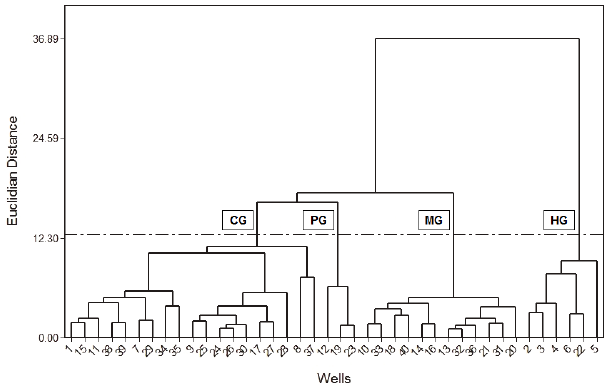
areas of urbanized Guadalajara, except for Toluquilla wells where values ascend to 2300 µS cm − 1 . The CG ( n = 19) is a Na-HCO 3 water type located in recharge zones in the west- ern portion and reflects a short (local) groundwater flow path with poor circulation. It shows low temperatures (av- erage 25.3 ◦ C) and salinity (254 µS cm − 1 ) , however elevated NO 3 -N (9.1 mg L − 1 ) values, possibly derived from agricul- tural practices. Groundwater in the discharge area in cen- tral Guadalajara evolves to a Na-SO 4 to mixed-HCO 3 water type (PG, n = 3), with higher concentrations of several ele- ments, indicating an important impact from anthropogenic pollution, i.e., SO 4 (70.6 mg L − 1 ) , NO 3 -N (12.4 mg L − 1 ) , Na (52.2 mg L − 1 ) and Cl (38.9 mg L − 1 ) .Groundwater that moves in northern and eastern direction attains a Na- HCO 3 to mixed HCO 3 water type (MG, n = 12), with in- creased temperatures (30.2 ◦ C) but similar low salinities (300 µS cm − 1 ) , indicating water–rock interactions. Finally, water that moves from the recharge zone at Primavera caldera southeast towards the central part of Toluquilla Val- ley attains a Mg-HCO 3 and mixed HCO 3 -type (HG, n = 6). These wells show highest temperatures (33.8 ◦ C) and salinity (EC = 1.575 µS cm − 1 ) , and lowest NO 3 -N (0.17 mg L − 1 ) . This preliminary evaluation of the evolution of ground- water chemistry along principal flow paths indicates that groundwater flow is affected by different sources. In the cen- tral and northern part of the study area, local groundwa- ter from La Primavera caldera undergoes water–rock inter- actions and mixes with mountain-front recharge as well as return flow from agricultural plots and urban water cycling (Fig. 3, Sects. I and II), while in the southern portion, local water mixes with water from deeper formations that interacts with volcanic rocks of the La Primavera caldera and causes increased mineralization and temperatures (Fig. 3, Sects. I and